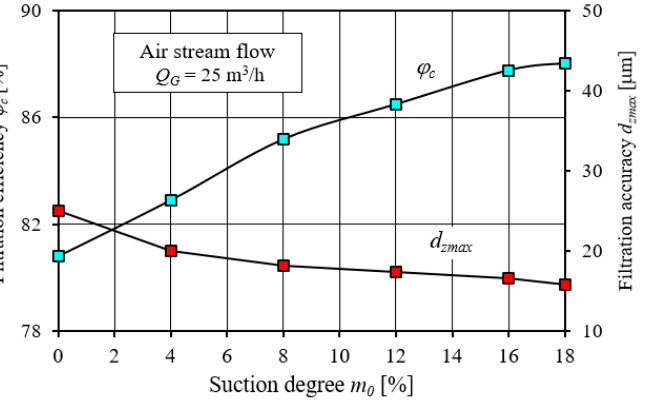
Figure 12. The impact of the suction rate m 0 on the filtration efficiency and accuracy of the pass- through cyclone.